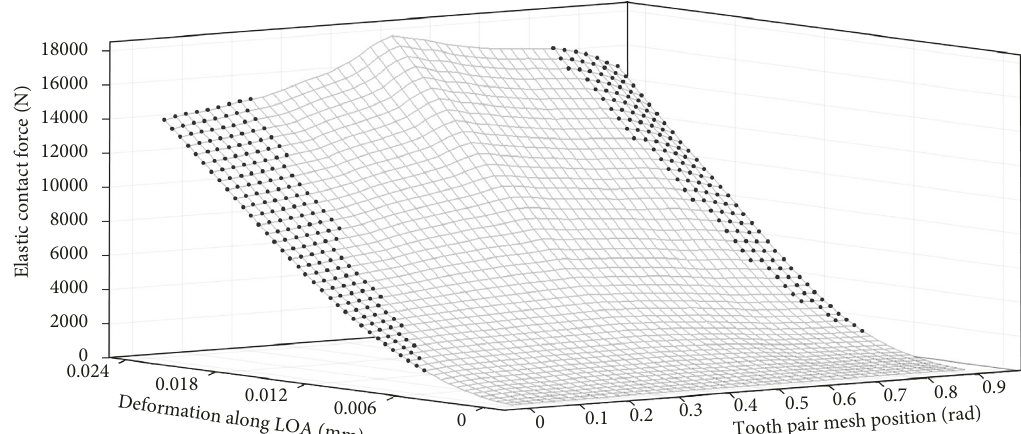
Figure 14: Relationship between the tooth contact force and its corresponding deformation along the line of action at each mesh position.